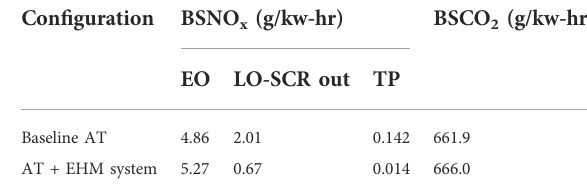
TABLE 9 WHTC Composite test results.